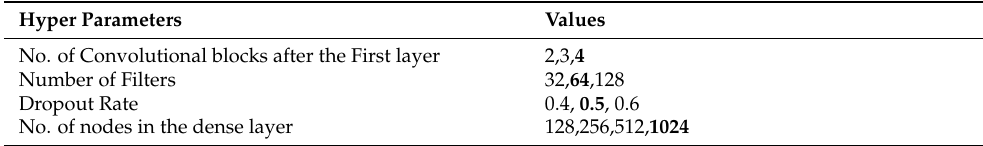
Table 3. Hyperparameter Selection.